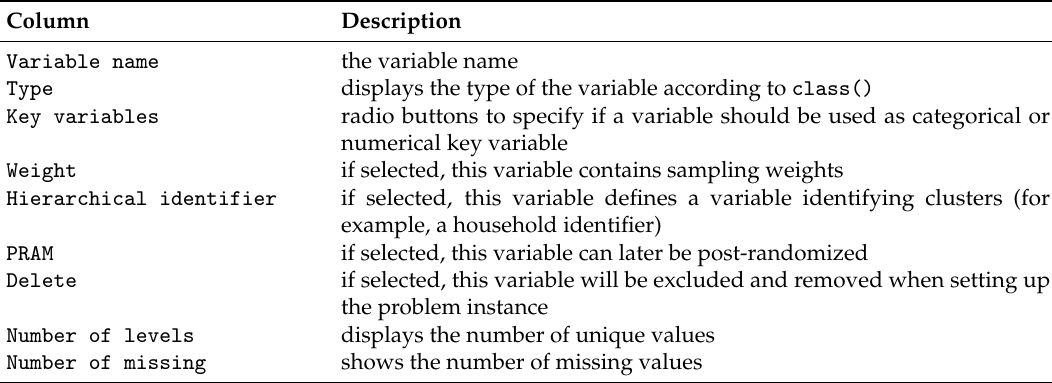
Table 3. Interactive table when defining a problem